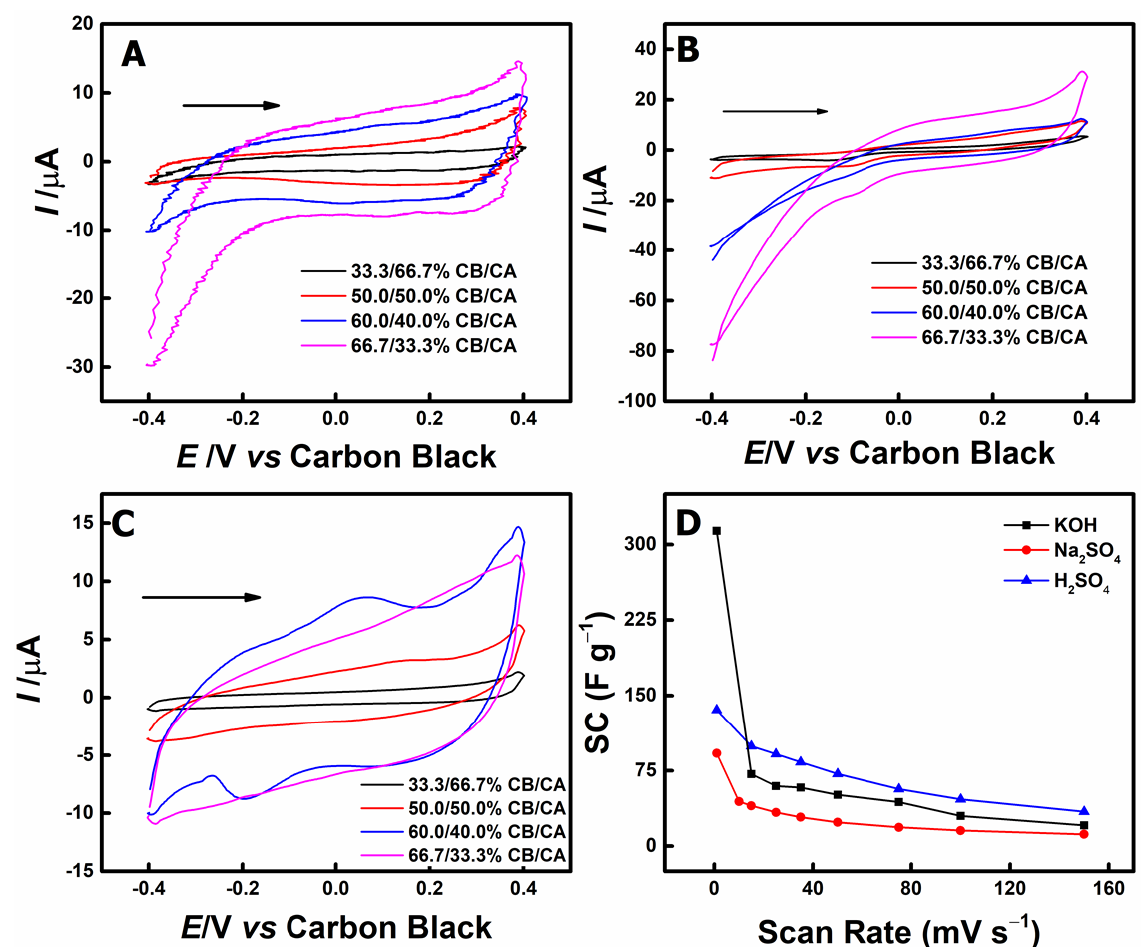
Figure 2. Cyclic voltammograms of different CB/CA formulations: 33.3/66.7 ( black ), 50.0/50.0 ( red ), 60.0/40.0 ( blue ), and 66.7/33.3% ( pink ); in ( A ) 1.0 mol L − 1 H 2 SO 4 , ( B ) 1.0 mol L − 1 KOH, and ( C ) 1.0 mol L − 1 Na 2 SO 4 ; ν = 10 mV s − 1 ( D ) SC vs. scan rate plots for 66.7/33.3% CB/CA at equimolar 1.0 mol L − 1 H 2 SO 4 ( ▲ ); Na 2 SO 4 ( ● ) and KOH ( ■ ) solutions.